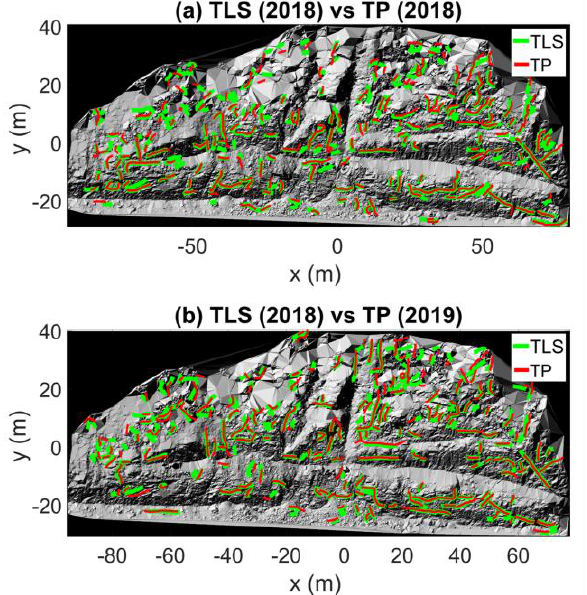
Figure 8. Matched edges in the Glenwood Canyon dataset (a) TLS (2018) versus TP (2018); (b) TLS (2018) versus TP (2019).